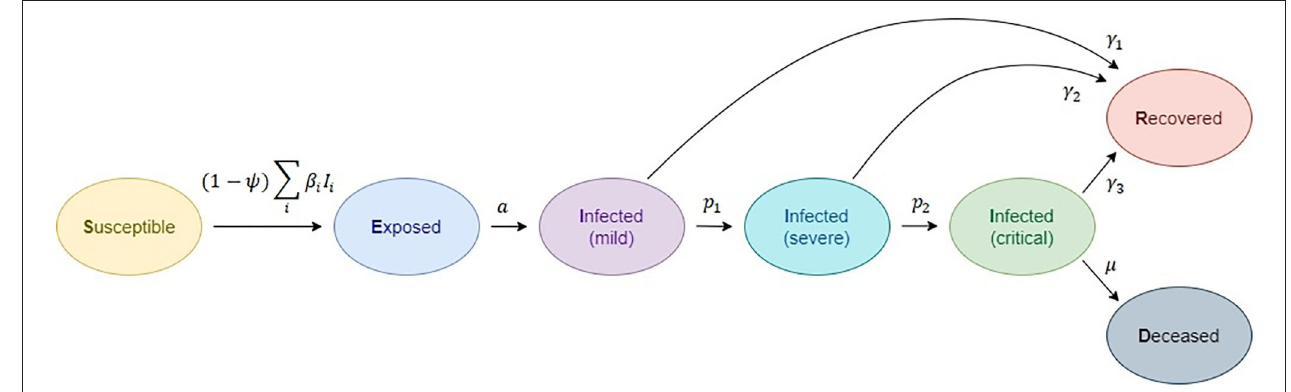
FIGURE 1 | Compartmental epidemiological model, based on the classic susceptible, exposed, infected (1- mild, 2-severe, 3-critical), recovered, deceased (SEIRD)